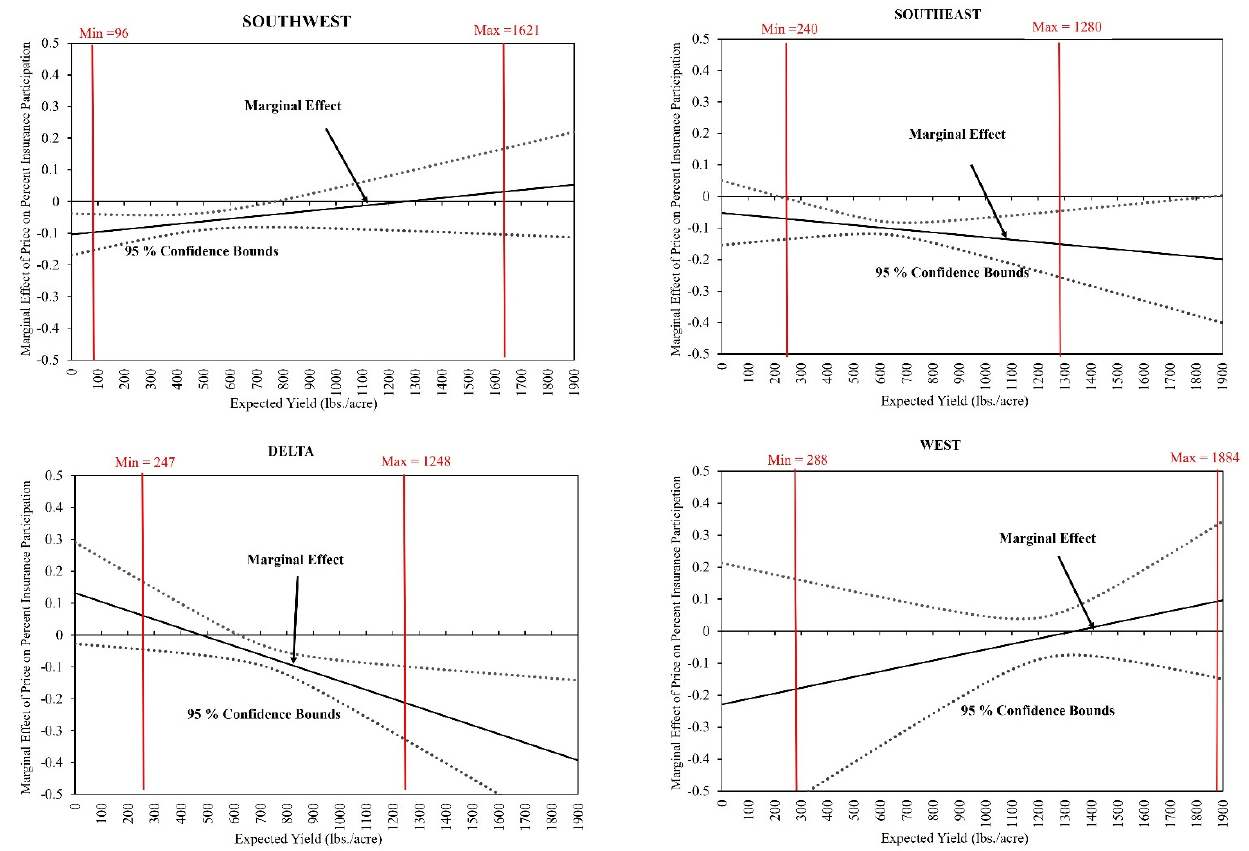
Figure 5. Marginal effects (by region) of expected price on insurance participation given expected yields.